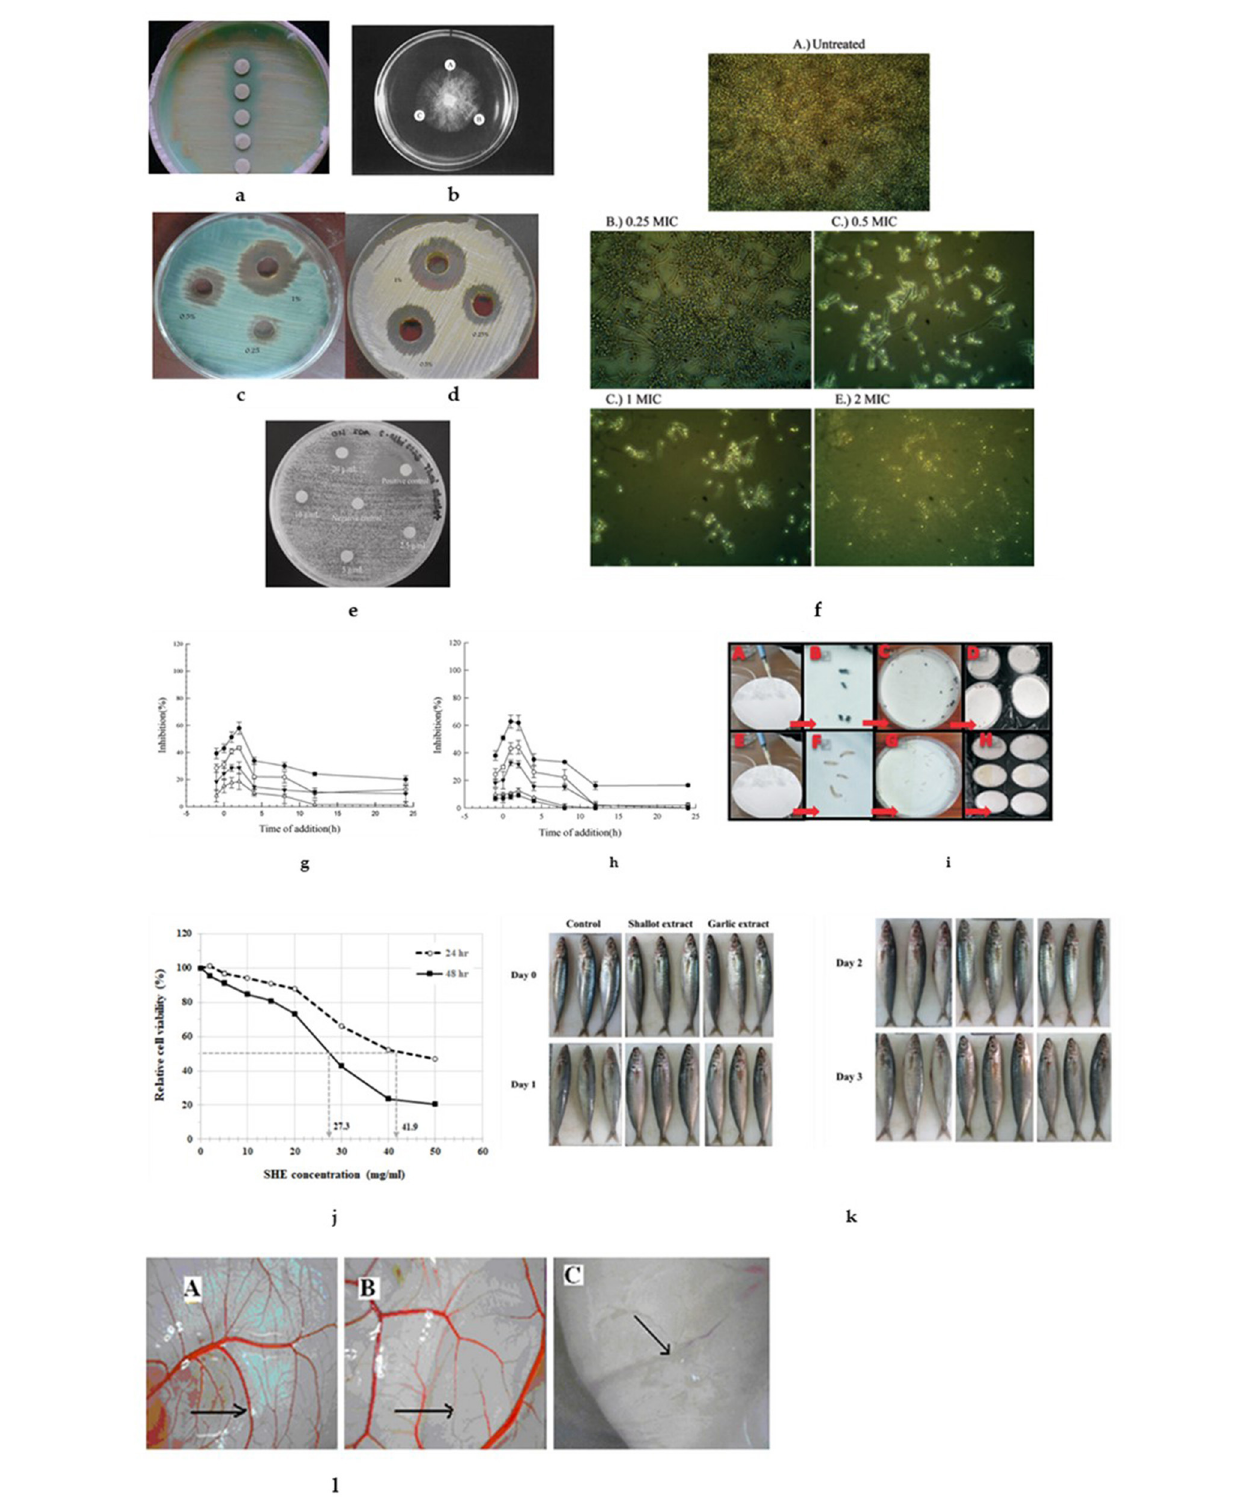
FIGURE 2 | Antimicrobial effects of shallot. (a) Antimycobacterial activity of partially purified extract of Allium ascalonicum . (b) Anti-fungal activity of ascalin against B. cinerea . (A) Control, (B) Ascalin (75 µ g), and (C) Ascalin (15 µ g). Shallot extract effect on (c) Penicillium sp., (d) Candida albicans, (e) Allium ascalonicum aqueous extracts inhibited the growth of Candida albicans. (f) Biofilm formation observed after 24h with shallot extract (A) without treatment (B) 0.25 MIC, (C) 0.5 MIC, (D) 1